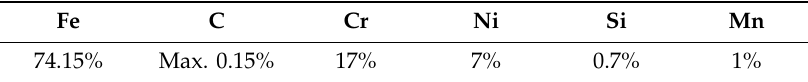
Table 1. Chemical composition of NICRO 12.1. Data from [18].